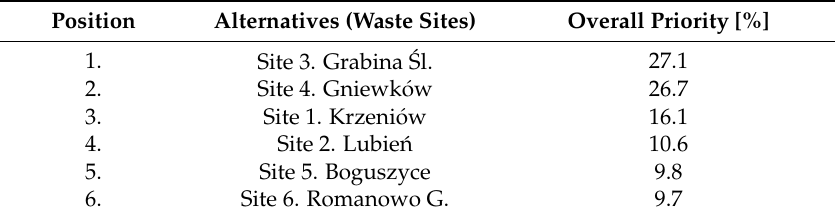
Table 4. Results of overall priority